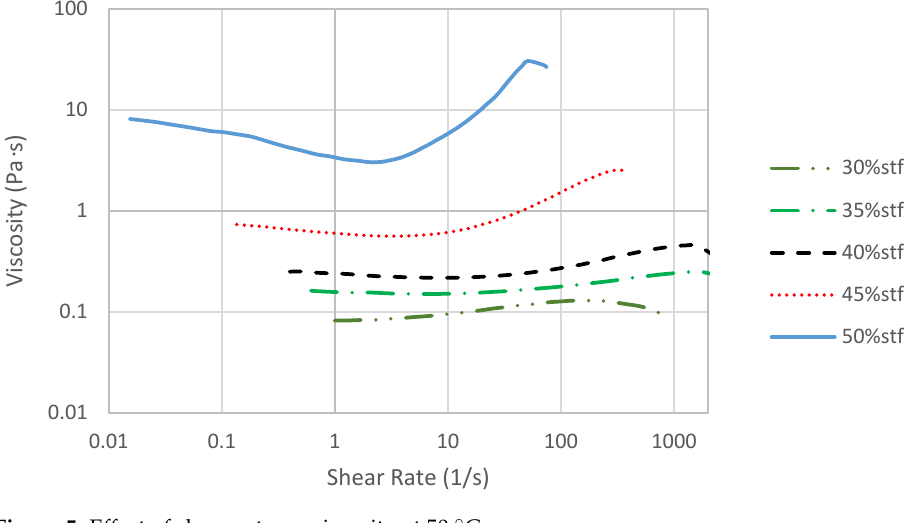
Figure 5. Effect of shear rate on viscosity at 50 °C.